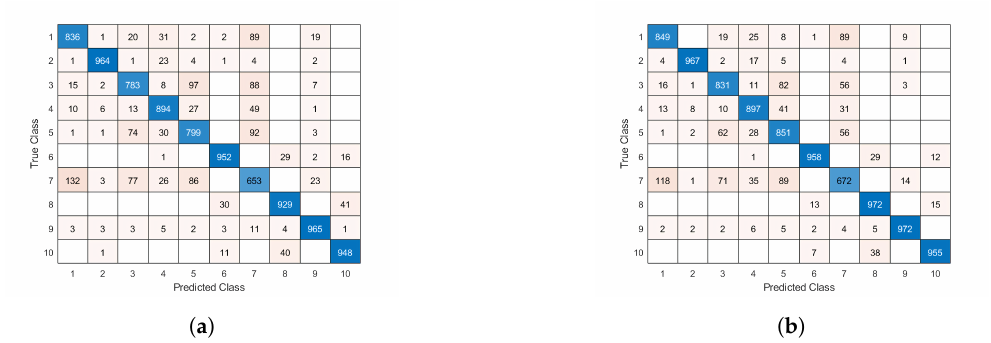
Figure 14. Confusion matrix of ( a ) the vanilla Fashion MNIST network topology and ( b ) the adaptive Fashion MNIST network